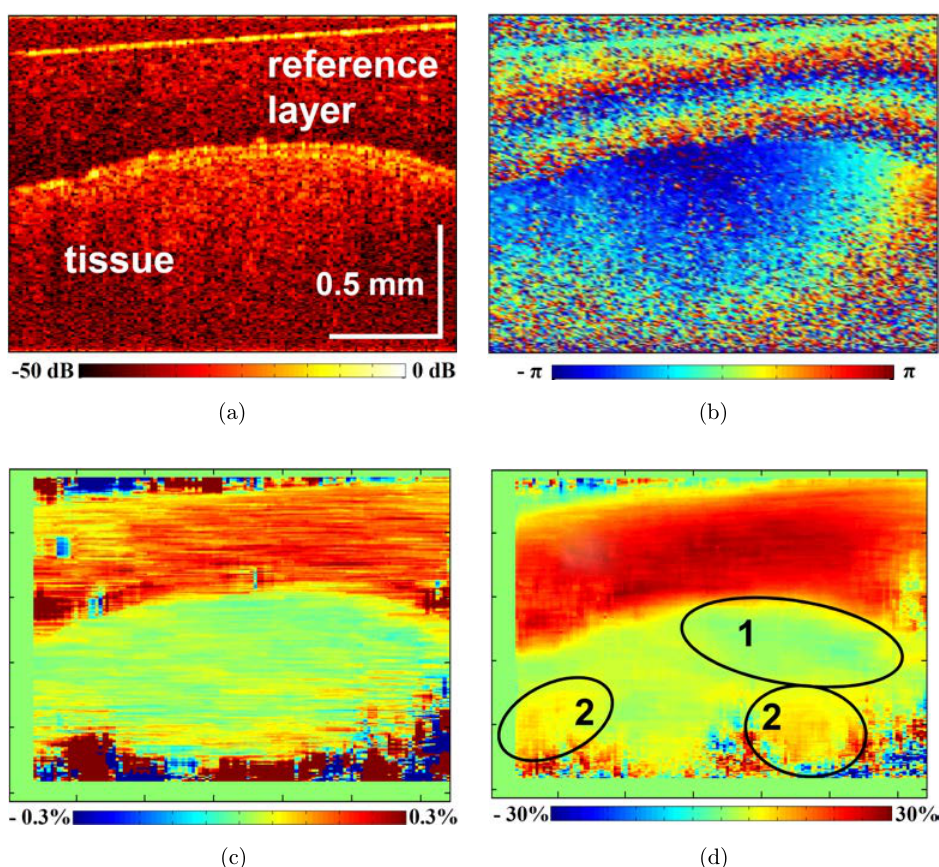
Fig. 4. Use of a translucent reference sensor layer for OCE imaging of tissue with uneven surface and inhomogeneous distribution of sti®ness (a tumor inoculated in a mouse ear): (a) structural OCT image showing the °at probe – sensor layer interface, homog- enous and deformed sensor layer, and underlying tissue with an uneven surface (protruding tumor). Contours 1 and 2 mark the tumor region and underlying normal tissue, respectively, (b) color map of phase di®erence between a reference and deformed frames; note the regular phase variation in the reference layer (indicative of its homogeneity) and irregular phase behavior in the underlying heterogeneous tissue, (c) corresponding map of interframe strain, and (d) cumulative strain accumulated over (cid:3) 130 frames during monotonic compression. Both (c) and (d) exhibit higher strains in the silicone layer (as expected), and lower/heterogenous strains in tissue; cumulative strain maps such as (d) are able to better visualize lower-strain tumor region 1 (encircled) and higher-strain regions 2 (encircled) of softer nearly normal tissue beneath the